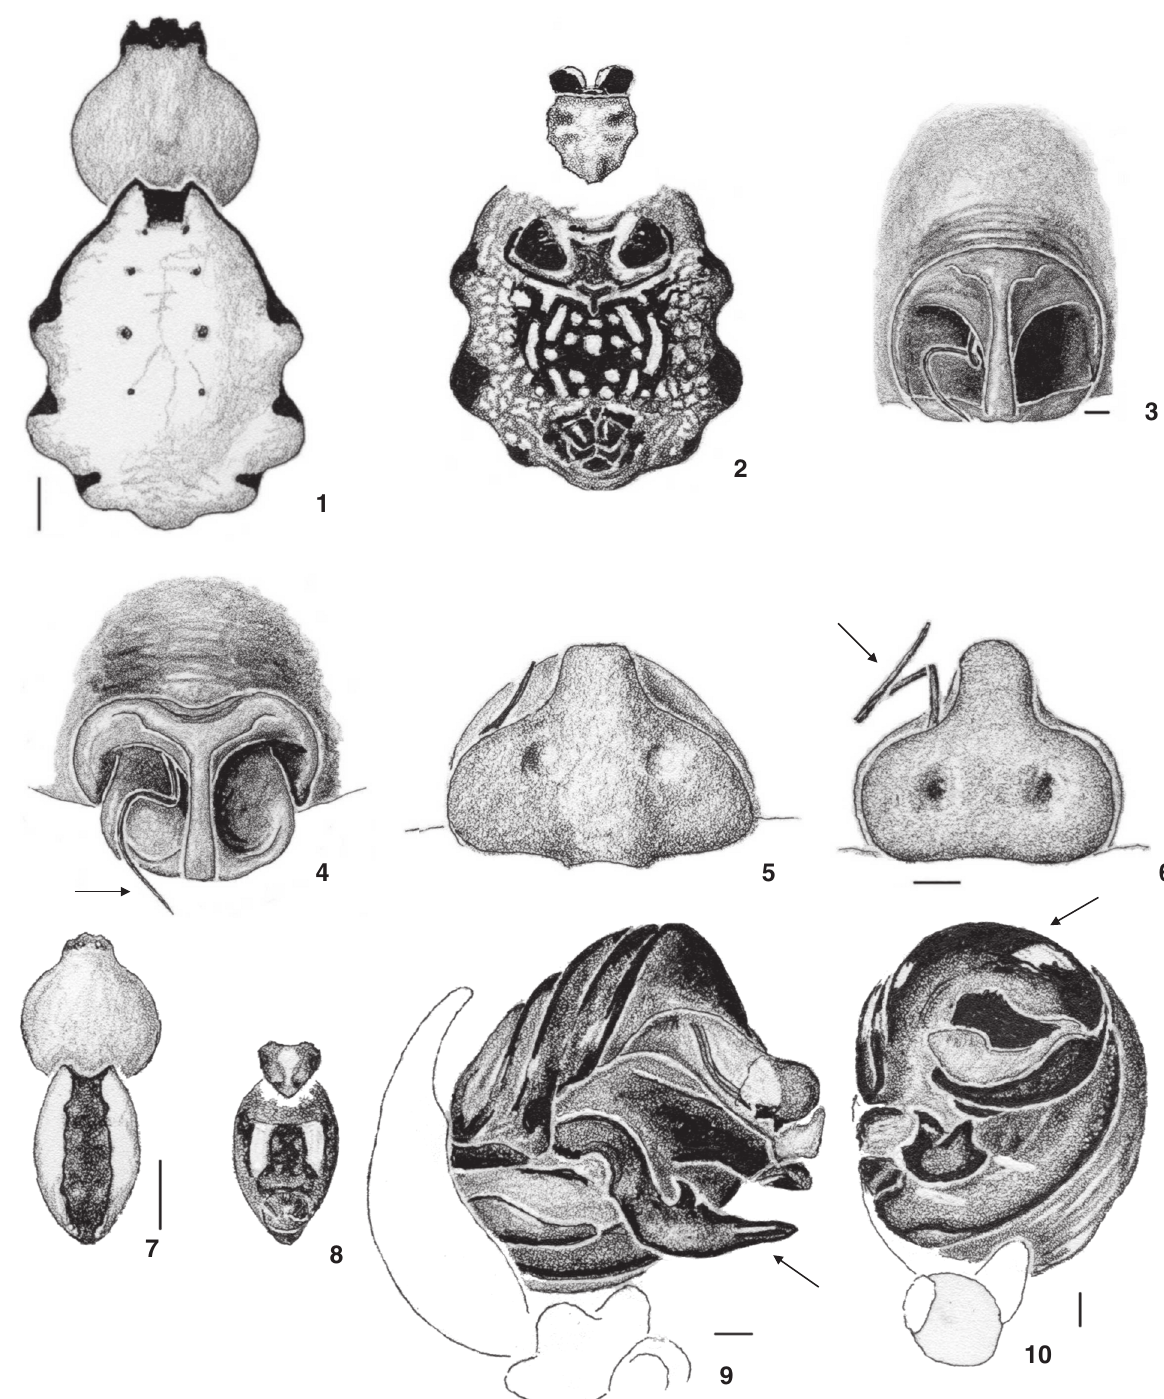
Figures 1-10. Argiope legionis sp. nov. (1-6) Female: (1) carapace and abdomen; (2) sternum and abdomen, ventral; (3-6) epigynum, arrows, male embolus: (3) ventral; (4) lateral; (5-6) posterior. (7-10) Male: (7) carapace and abdomen; (8) sternum and abdomen, ventral; (9) palpus, ventral, arrow, median apophysis; (10) palpus, mesal, arrow, conductor. Scale lines: 1.0 mm, genitalia: 0.1